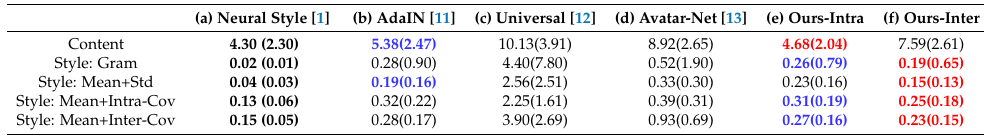
Table 1. Average (standard deviation) losses of various image style transferring methods. Red colored and blue colored values represent the best and the second best performances respectively.